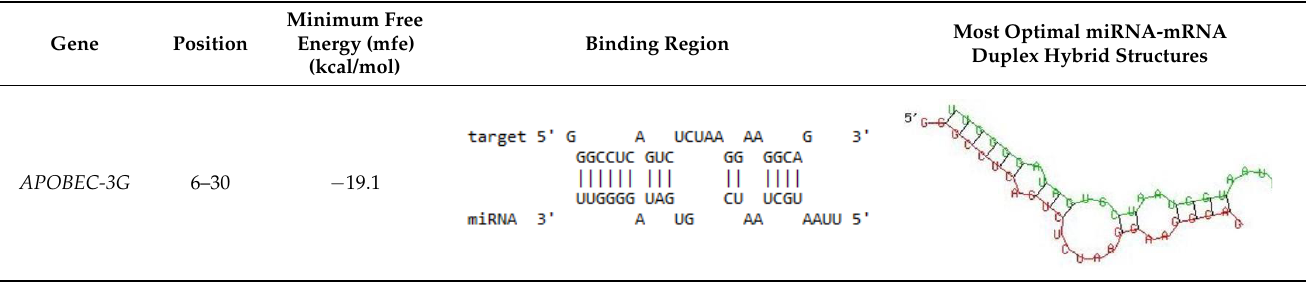
APOBEC- APOBEC-3G